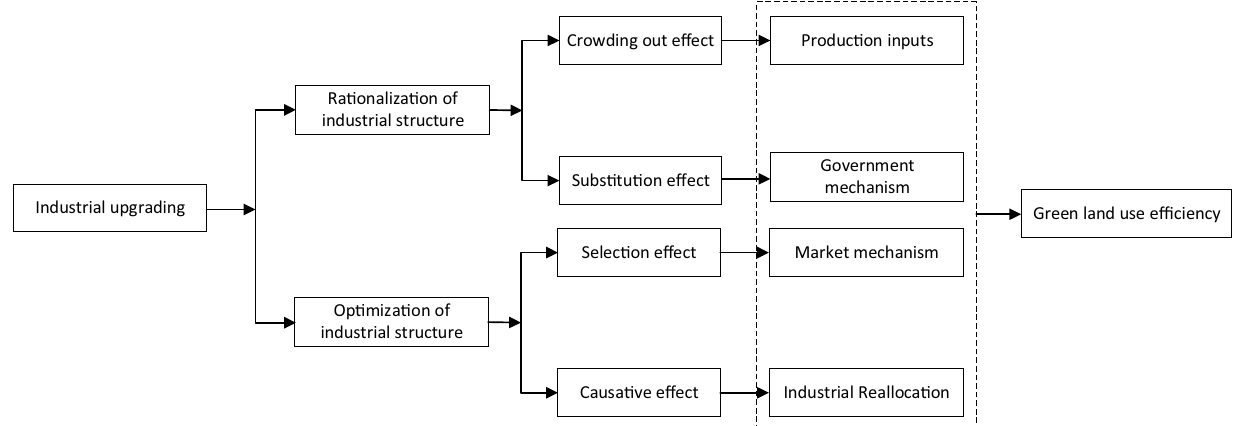
Figure 2. Influence path of Industrial upgrading on